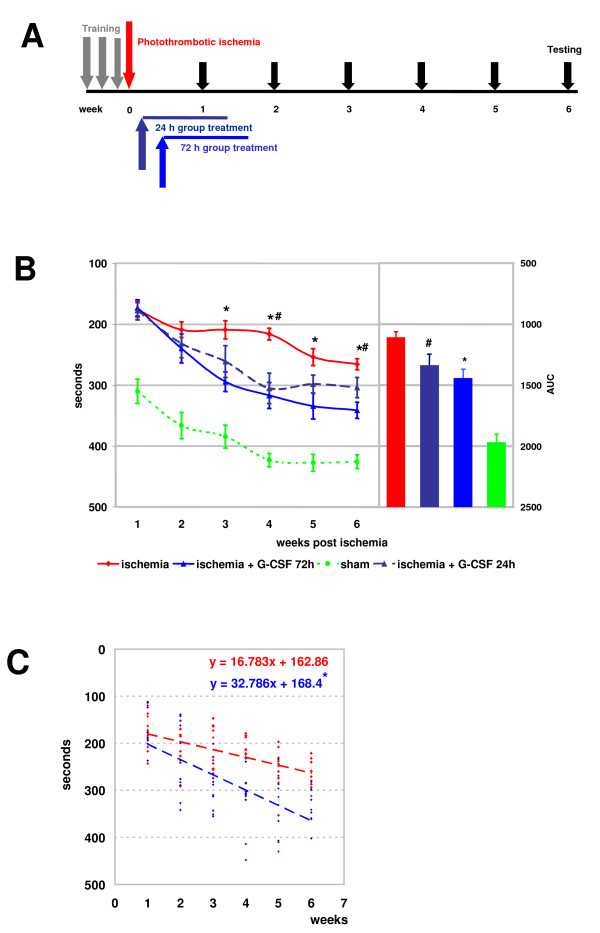
G-CSF improves functional outcome when given as late as 72 h after photothrombotic ischemia. A. Design of the cortical photothrombotic experiment. B. Rotarod performance over the course of 6 weeks after ischemia. Rats received 10 μg/kg bodyweight/day G-CSF for 10 days starting either at 24 or 72 h after ischemia. The effect is also detectable by an analysis of individual areas-under-the-curve (AUC). (*,#: p < 0.05 by ANOVA and Student-Newman-Keuls post-hoc test for 24 h (#) and 72 h (*) treatment). C. Linear regression analysis of vehicle treatment and G-CSF treatment initiated at 72 h demonstrates that slopes are significantly different by a factor of 2 (p = 0.004)